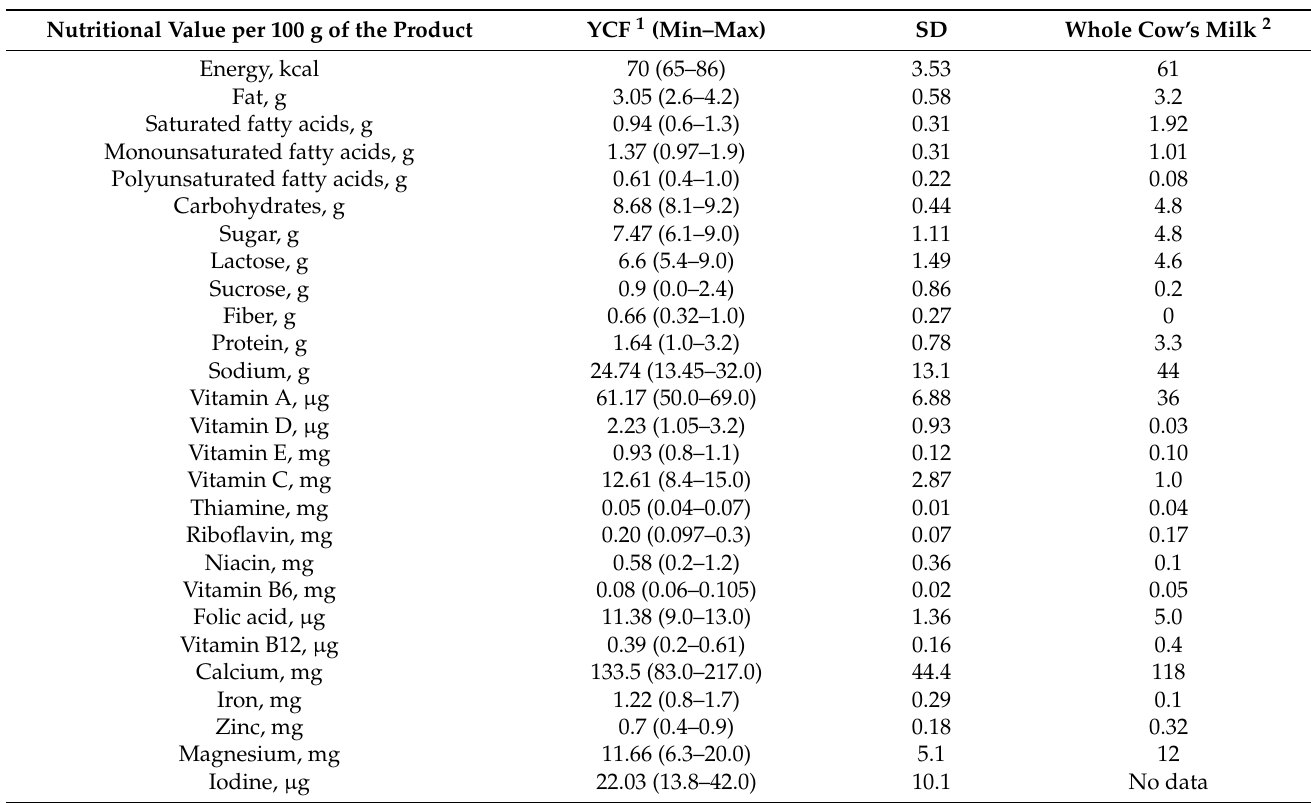
Table 3. Nutritional value of YCFs and whole cow’s